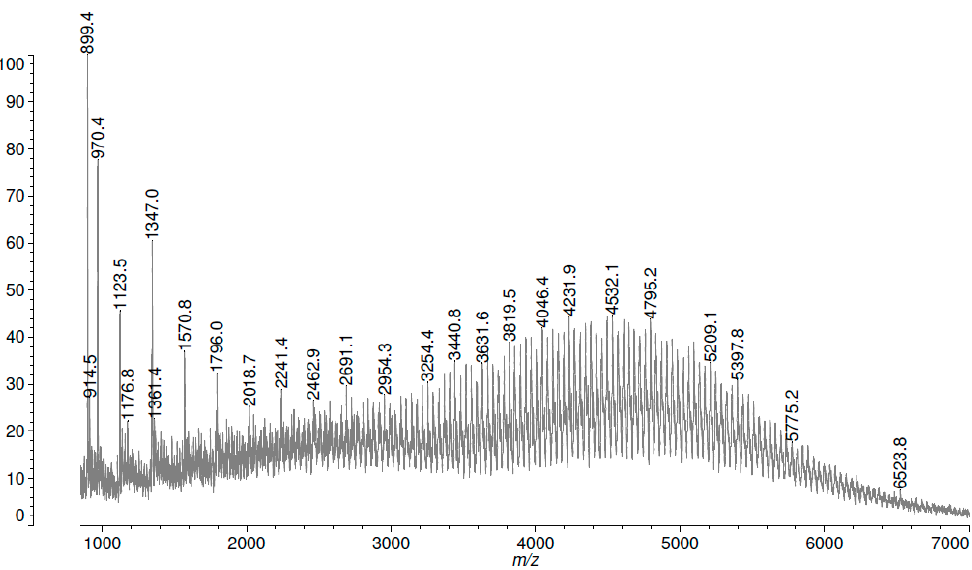
Figure 16. MALDI-TOF spectrum of AGE / PGE copolyether-diol (23). Table 11. Composition of AGE / PGE random copolyether–diol determined by MALDI-TOF mass spectrometry.